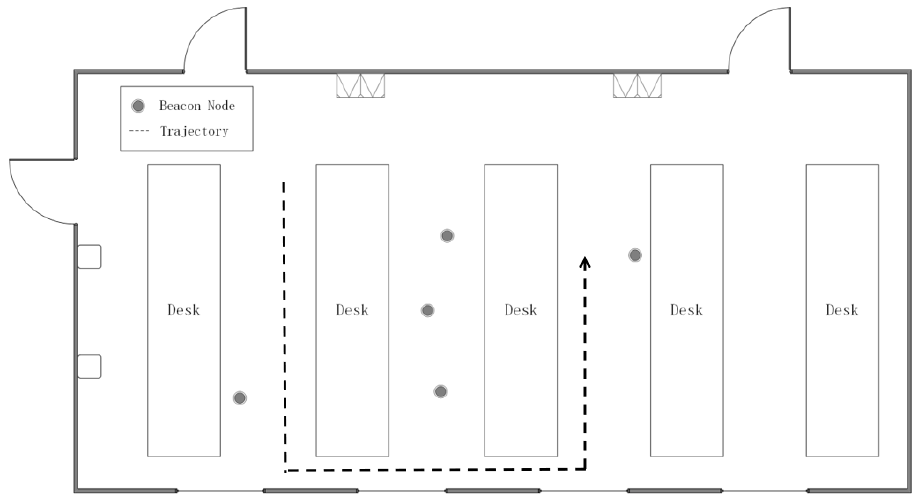
Figure 14. The floor plan of the experiment scenario in an indoor environment. Sensors 2020 , 20 , x FOR PEER REVIEW